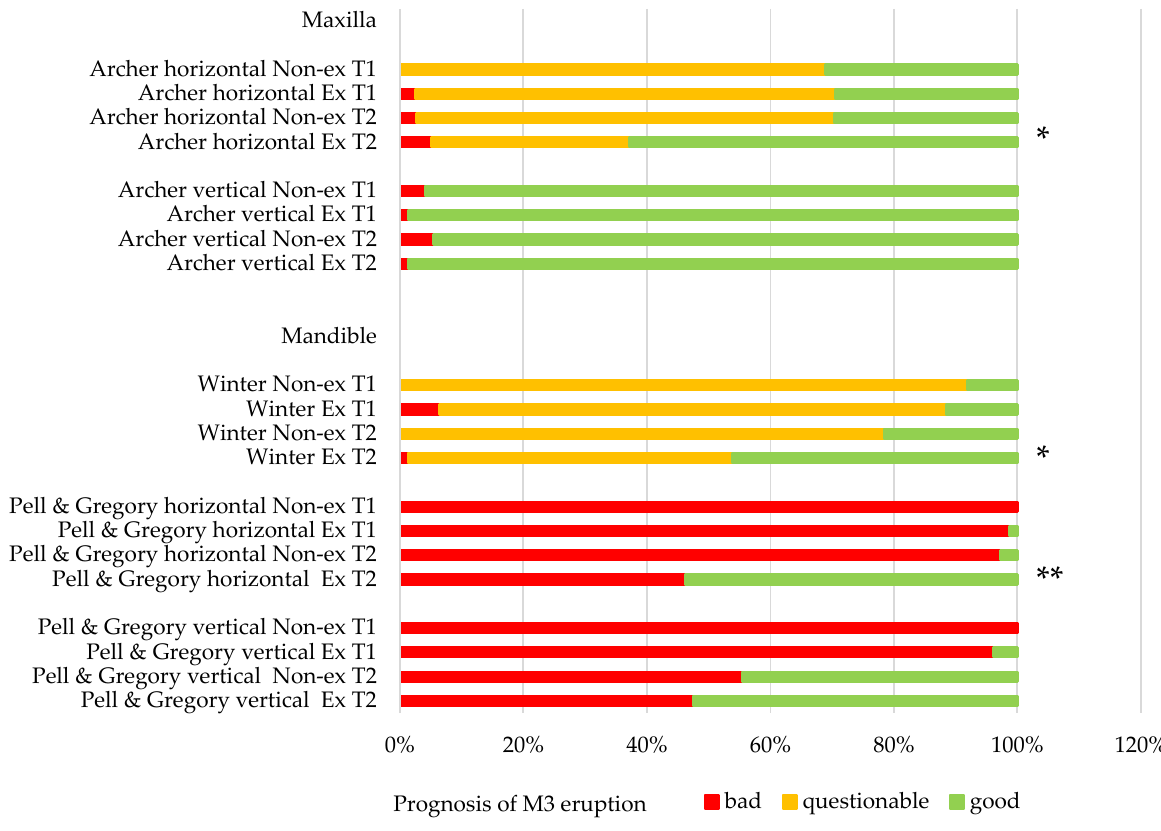
Figure 7. Distribution of the eruption prognosis of M3 in non-extraction (Non-ex) and extraction groups (Ex), before (T1) and after orthodontic space closure (T2) according to the different classification systems. * p < 0.05; ** p < 0.001.